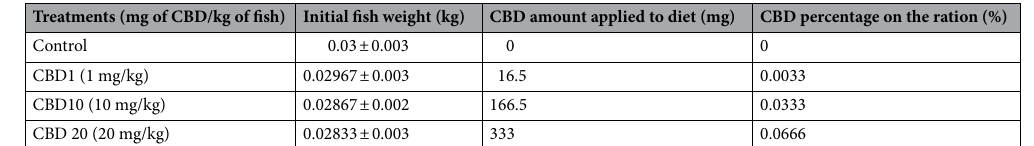
Treatments (mg of CBD/kg of fish) Initial fish weight (kg) CBD amount applied to diet (mg) CBD percentage on the ration